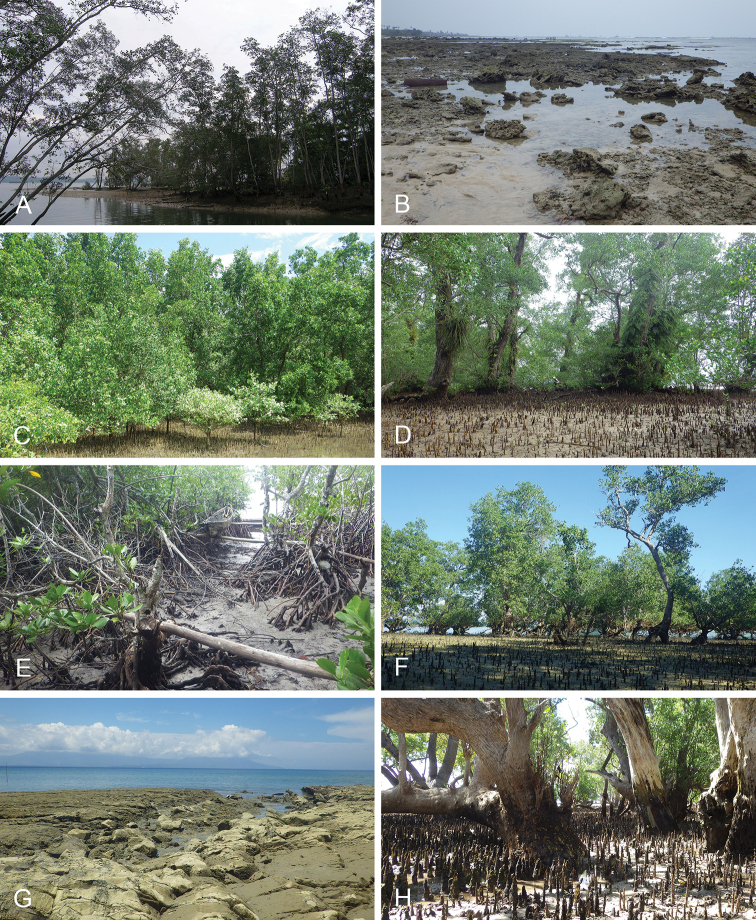
Habitats, Peronia
verruculata (unit #1) A Singapore B–H Indonesia A Mangrove forest with rich litter, lobster mounds, dead logs, with sand area near the creek (st 5) B Sumatra, coral rubble on beach exposed to estuary (st 78) C Sulawesi, old Sonneratia and Avicennia mangrove (st 84) D Ambon, narrow band of old Avicennia trees on sandy mud, old logs on ground (st 132) E Seram, mud next to a mangrove (st 135) F Lombok, old Avicennia forest with coral rubble (st 149) G Halmahera, rocky shore near a beach (st 217) H Timor, sandy part of mangrove with Sonneratia and Avicennia trees (st 250).